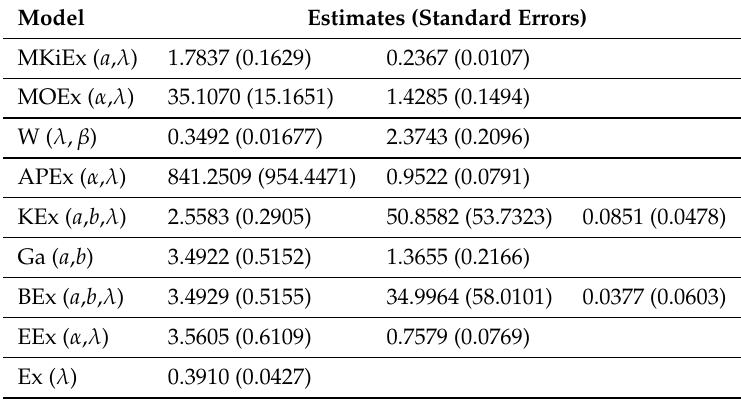
Table 7. Parameter estimates and standard errors for data set